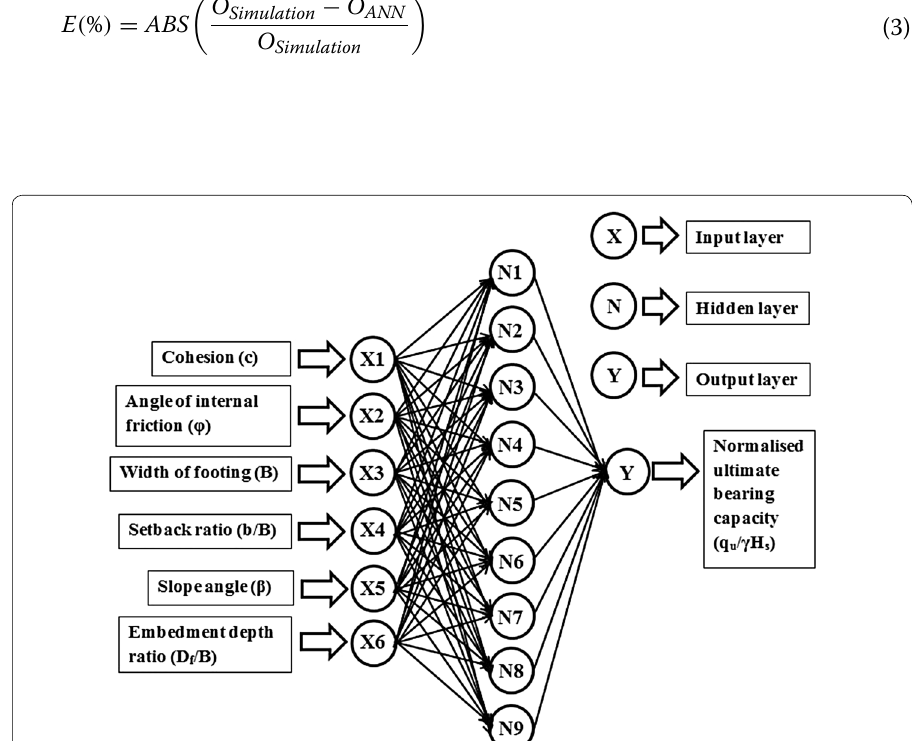
Fig. 5 Neural network architecture used in the